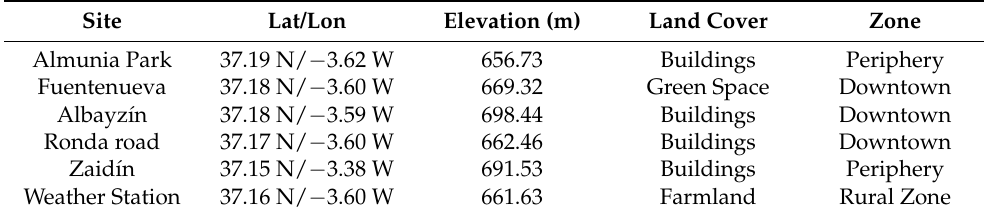
Table 2. Position and characteristics of the sites where the monitoring points were